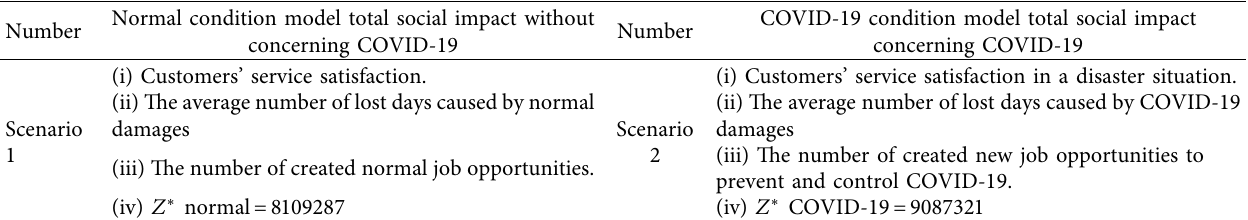
Table 6: The optimization value of the social OF with different scenarios.